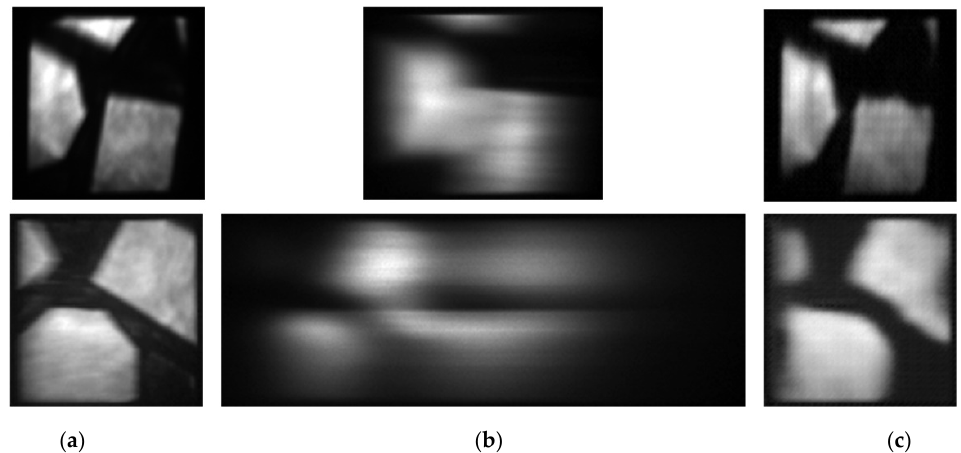
Figure 7. Reconstructed results with different spectral bands. ( a ) Captured light intensity. ( b ) Measured overlapped dispersive spectra. ( c ) Reconstructed light intensity.